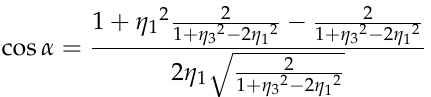
where α is the elevation angle of the transmission line with respect to the UAV. Figure 6 is a schematic diagram of the UAV carrying a sensor array for line patrol. When the straight line where the g2, g0, and g4 sensors are located is parallel to the transmission line, the electric field intensity induced by the two sensors is equal. When the straight line where g2, g0, and g4 are located intersects with the transmission line,